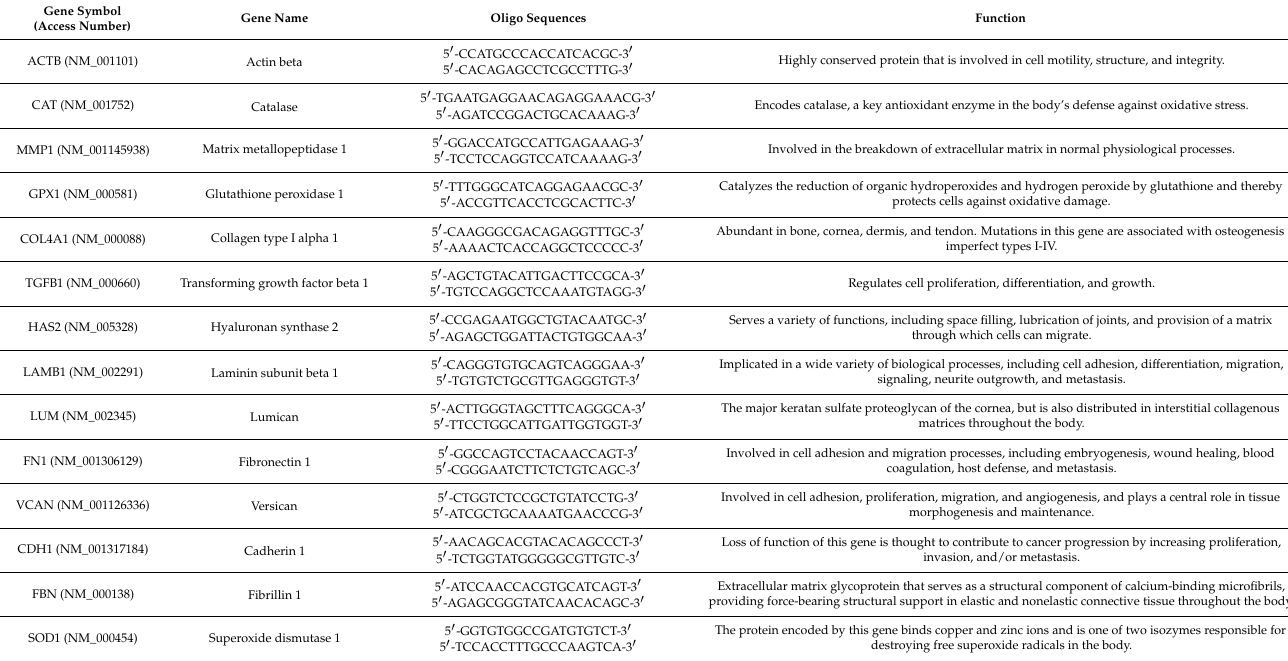
Table 1. Details of gene-specific used in RT-qPCR